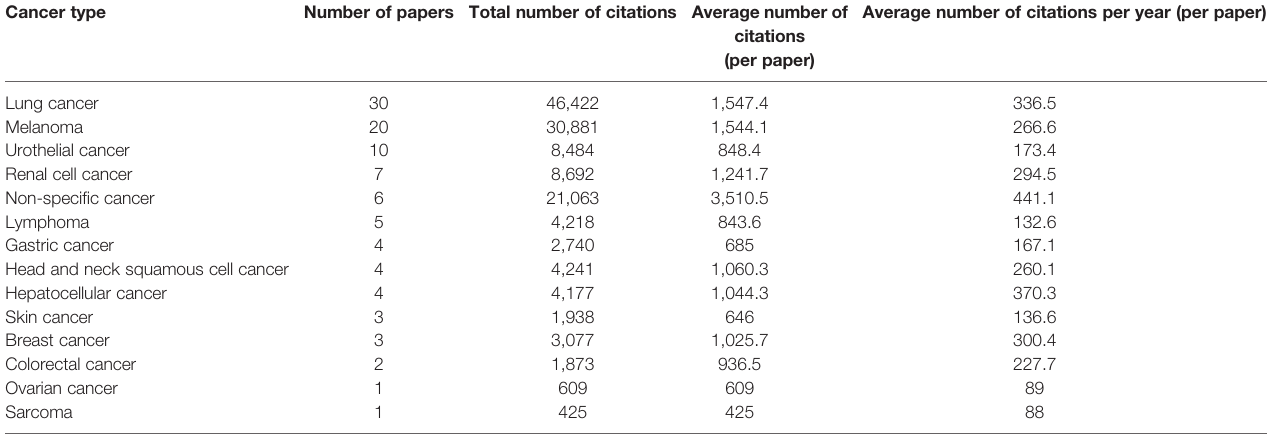
TABLE 4 | Types of cancers investigated in the top-cited papers on anti-PD1/PDL1 immunotherapy. Cancer